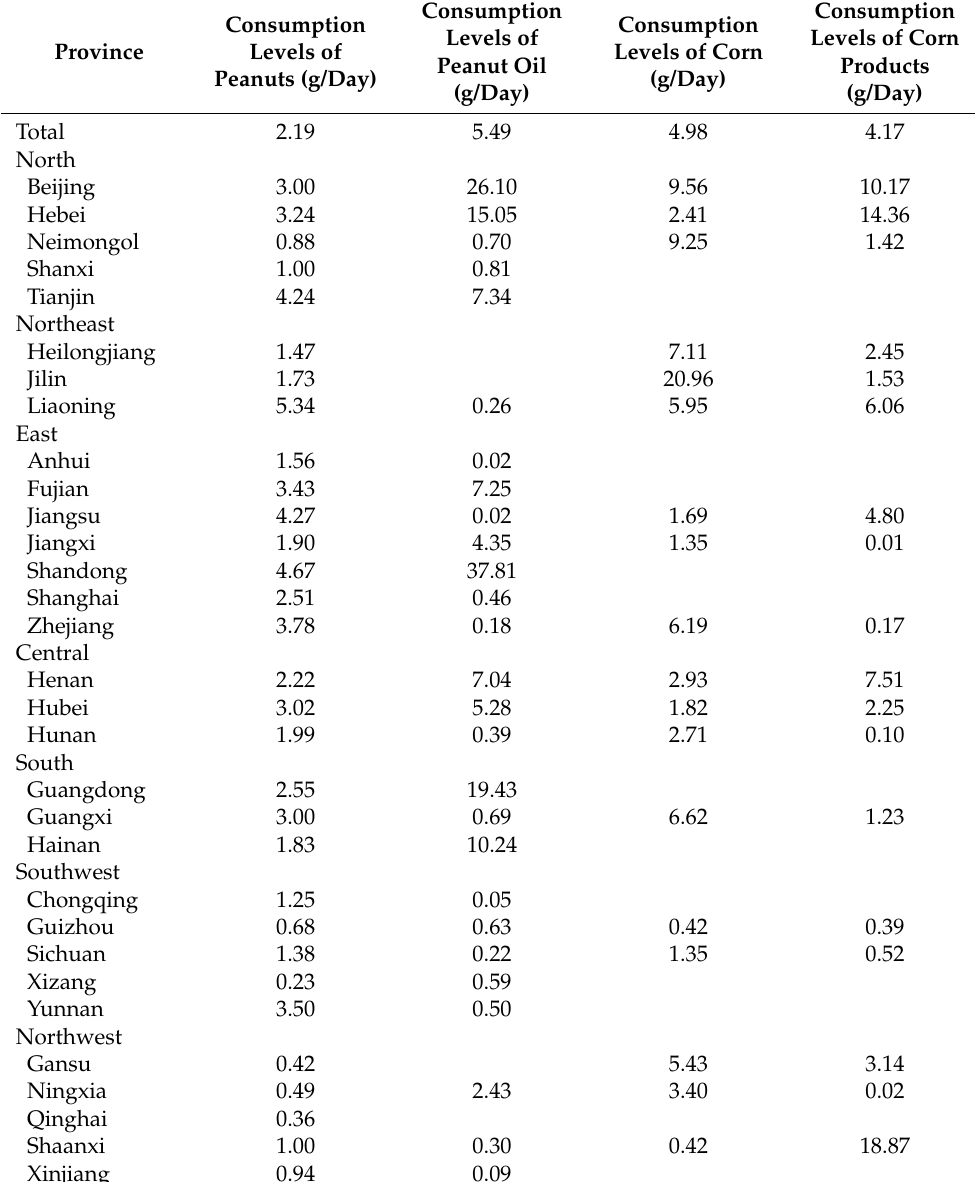
Table 2. The mean consumption levels of peanuts, peanut oil, corn, and corn products in different areas of China